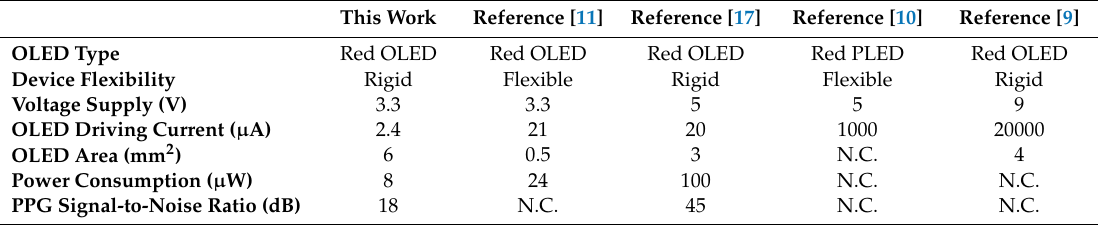
Table 3. Comparison table between our device and other